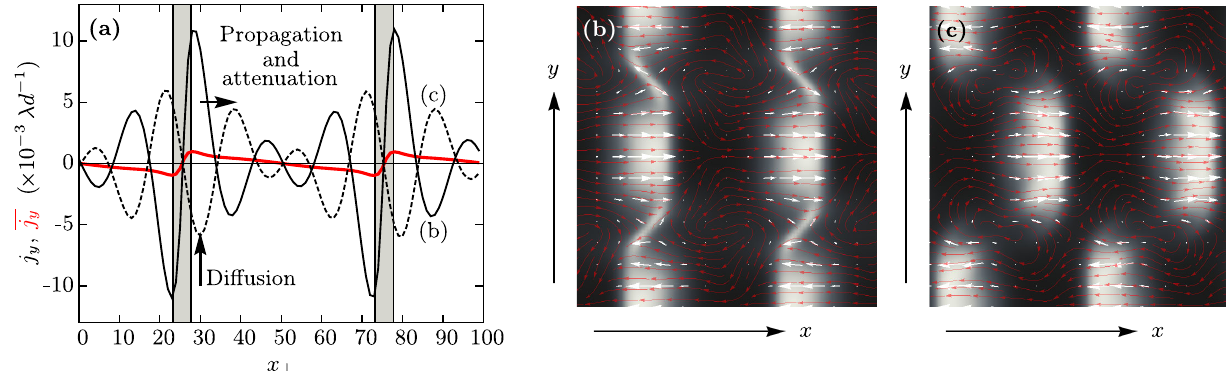
FIG. 6. Cluster-lane patterns. (a) Particle currents in the cluster-lane solution of the active Boltzmann equation. Black curves represent y; t Þ as functions of the (transverse) y coordinate instantaneous realizations of the longitudinally averaged, transverse particle currents j y ð taken at different instances of time; see the snapshots in (b) and (c). The red curve represents the time-averaged transverse particle y Þ . The gray shaded areas indicate the depletion zones where cluster grazing occurs, “ feeding ” the cluster zones (white currents j y ð areas). (b) Snapshot of a cluster-lane patten taken at the instant t 1 where the clusters of both lanes collide. (c) Snapshot of the same cluster-lane patten taken at some later instant t 2 > t 1 where the clusters of both lanes spread due to transverse diffusion. (b),(c) The color code indicates local density levels, white arrows indicate the magnitude and direction of the local momentum, and red streamlines indicate macroscopic flow